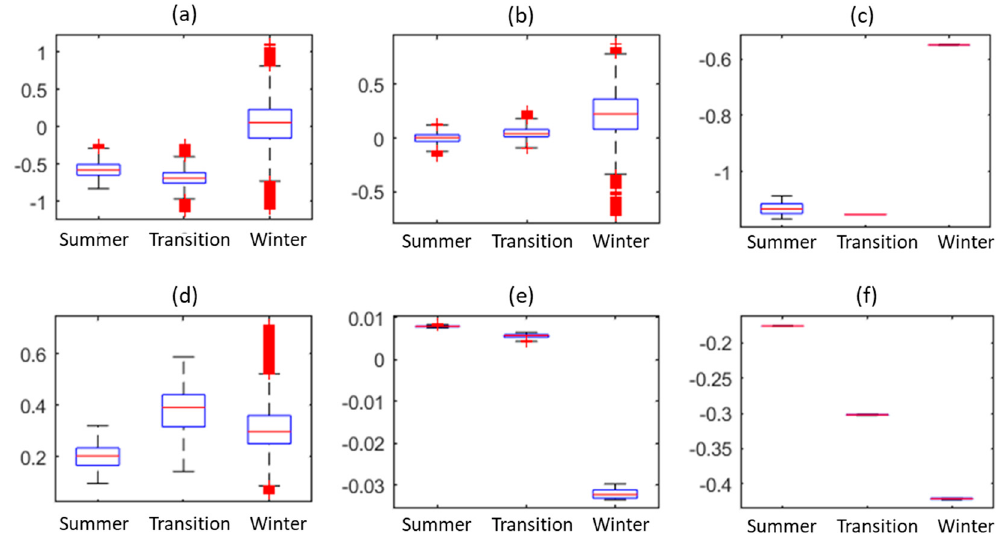
Figure 6. The boxplots of the slope coefficients of the six indicators for all seasons. ( a ) FVC, ( b ) albedo, ( c ) water percentage (WP), ( d ) building density (BD), ( e ) building height (BH) and ( f ) building volume density (BVD).